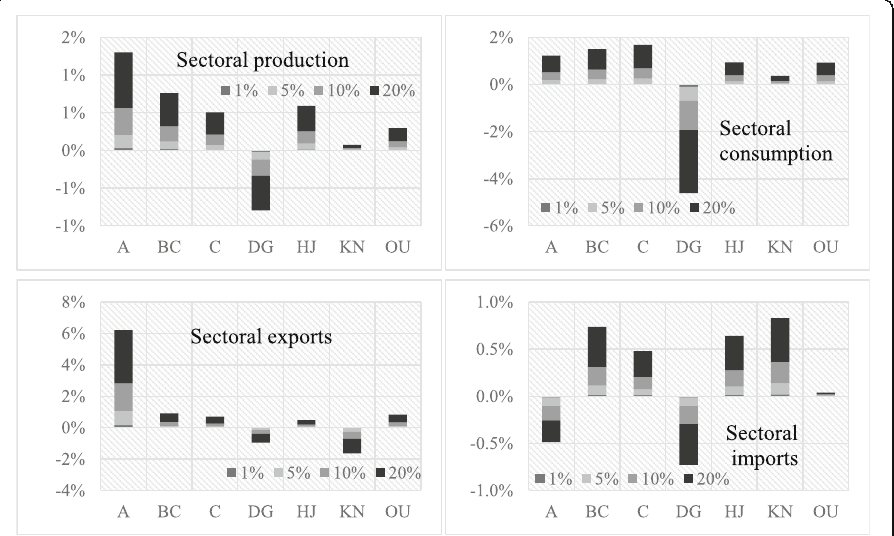
Fig. 12 Simulated sectoral effects of government revenue neutral subsidy for benefits provided by agriculture (neutralization based on consumption tax change). (Source: authors calculations based on CGE model simulations